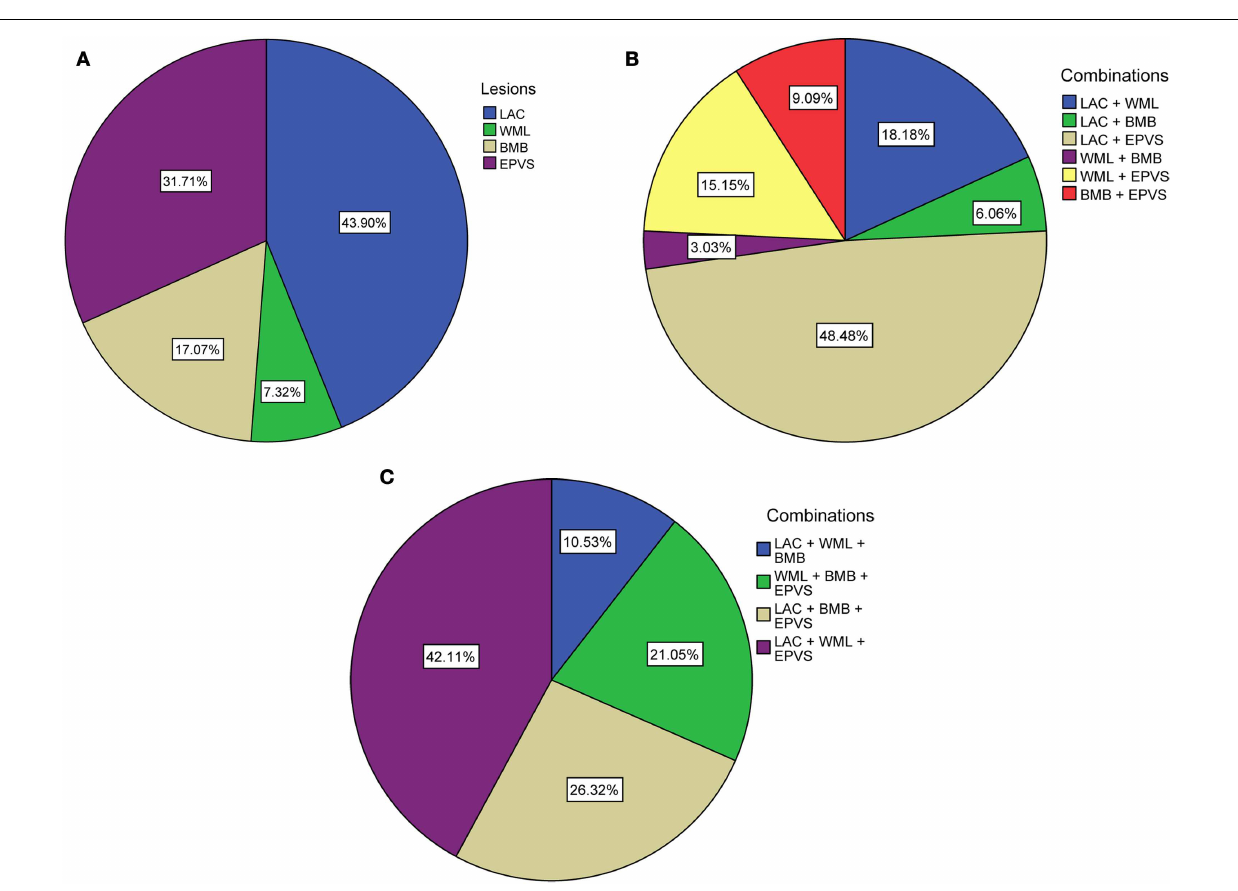
are present. (C) Percentages of the combinations when three lesions are present. LAC, asymptomatic lacunar infarcts;WML, white matter lesions; BMB, brain microbleeds; EPVS, enlarged perivascular